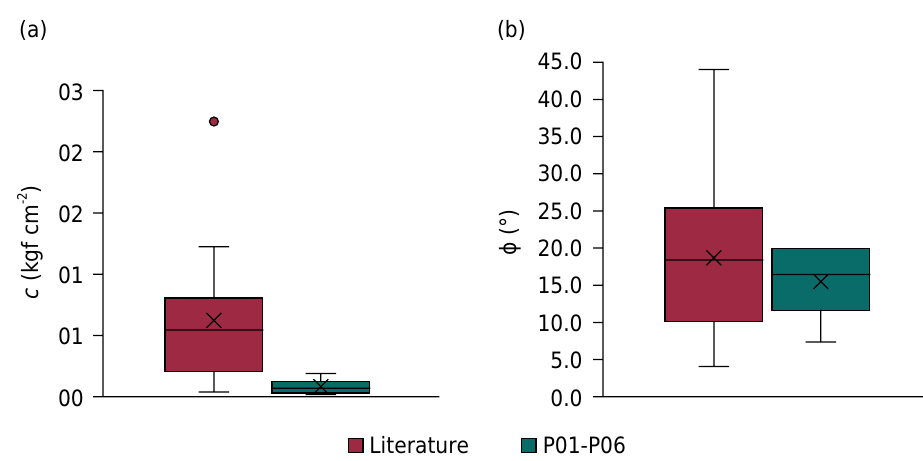
Figure 9. Cohesion (a) and friction angle (b) values recorded for Vertisols in Bahia State in comparison to values recorded for expansive soils mentioned in the literature (Table 9). c : cohesion; ϕ: friction